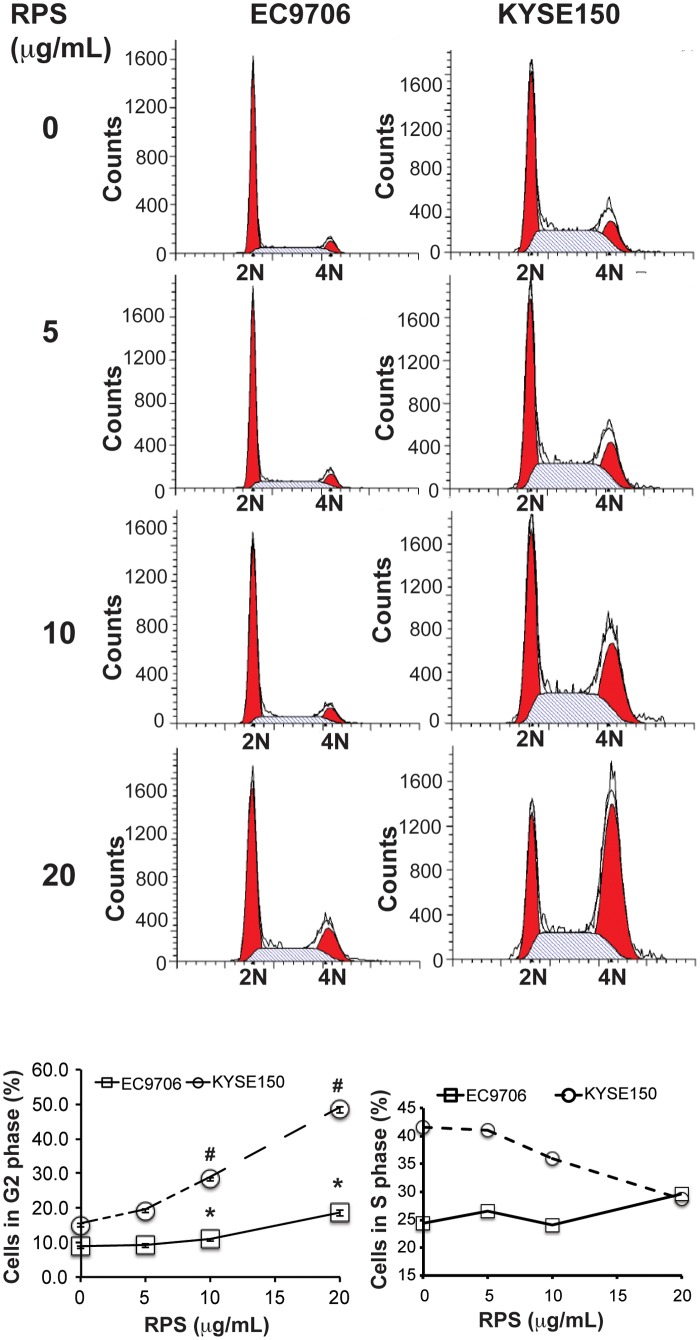
RPS promoted cell cycle G2/M phase arrest.Cells used for analyzing apoptosis were also analyzed for cell cycle using FlowJo software, n = 3. * and # represents significant difference at 5, 10, and 20 μg/mL of RPS compared to 0 μg/mL of RPS in EC9706 cell and KYSE150 cells, respectively, P < 0.01.